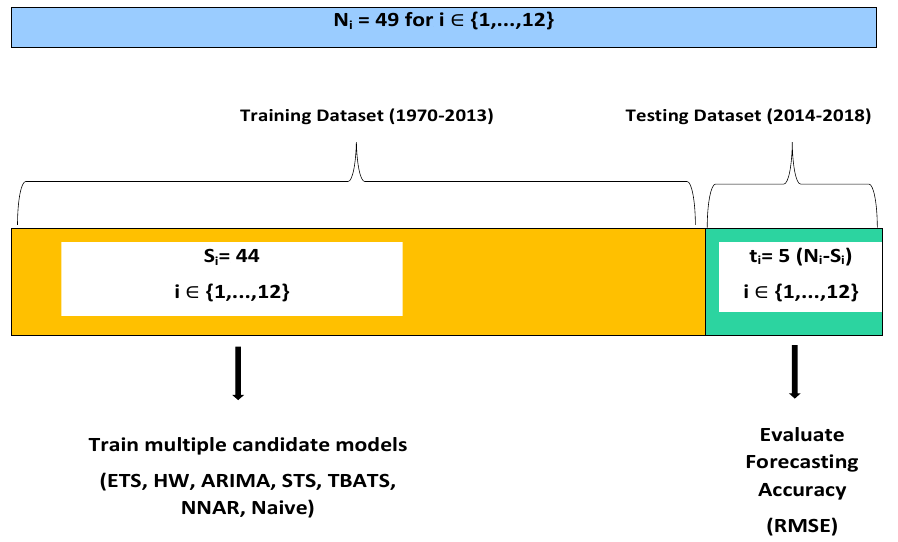
Figure 5. The holdout forecasting with training/test sets.